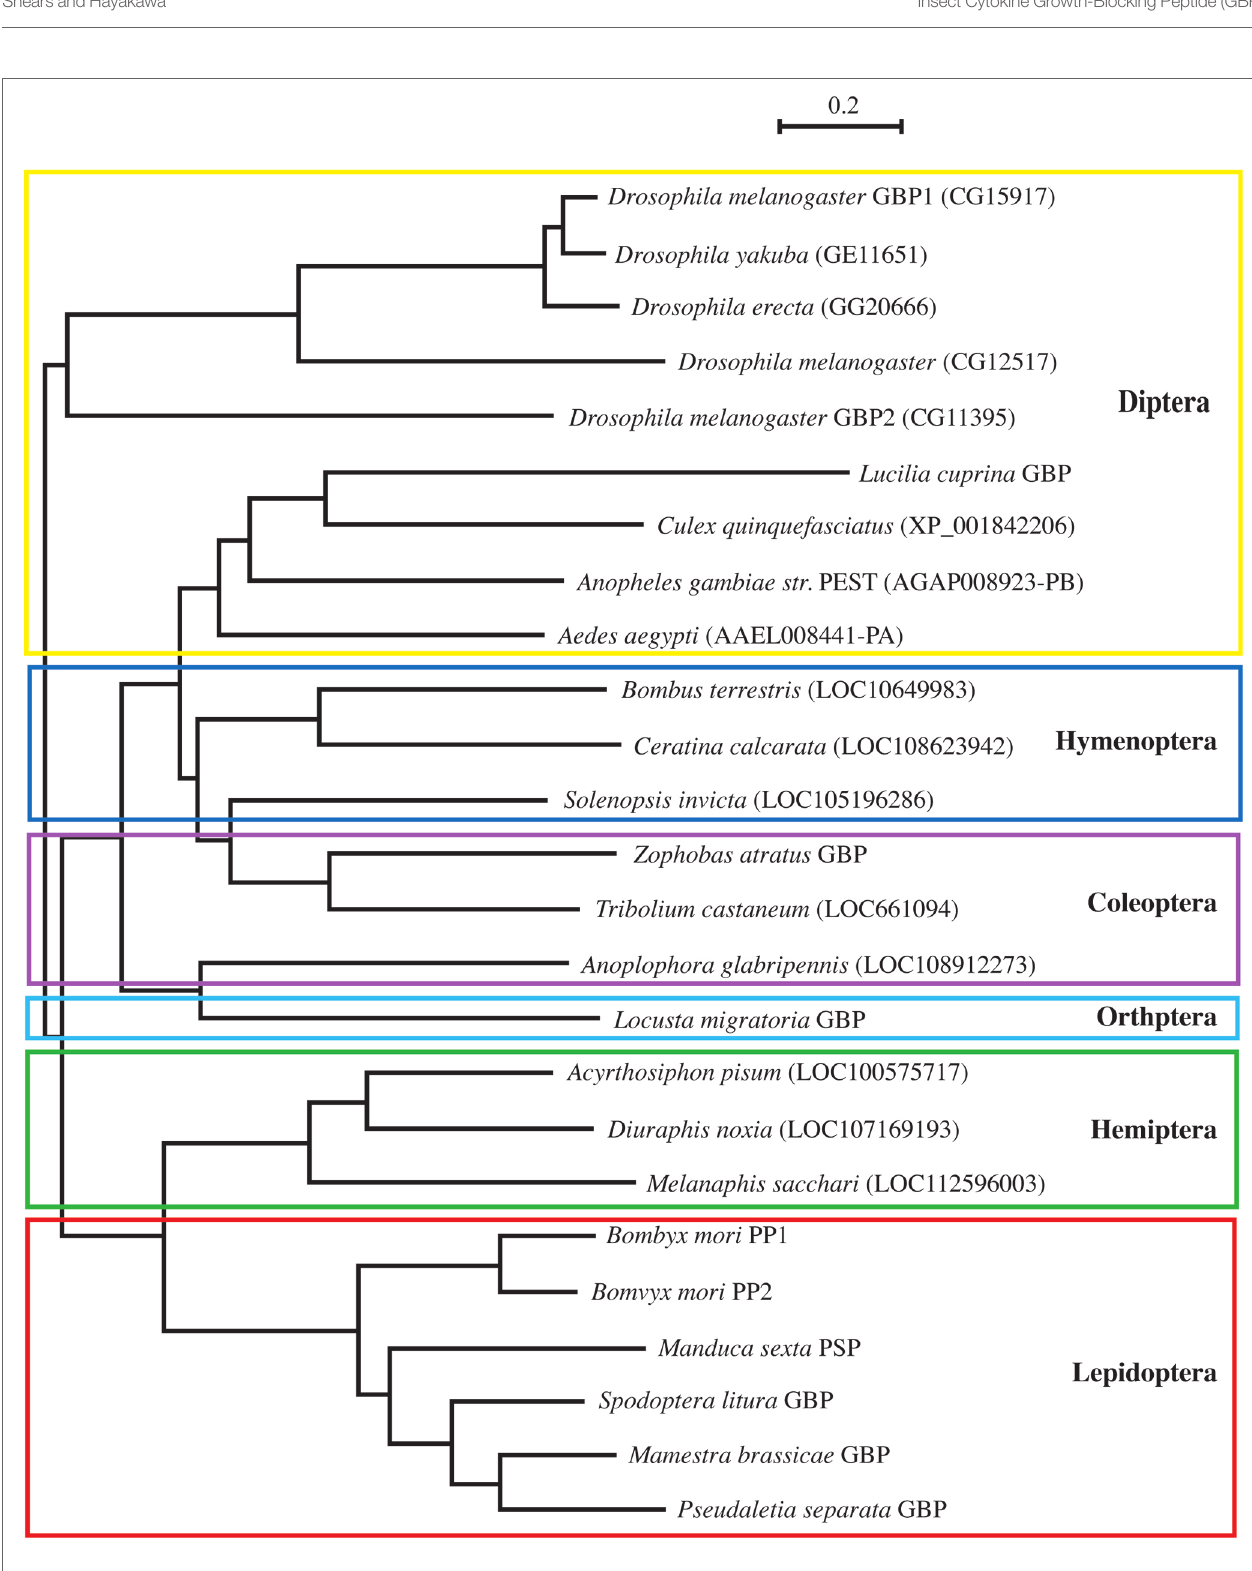
FIGURE 1 | A phylogenetic tree derived from precursor polypeptide sequences of GBP and GBP-like gene family spanning six orders of insects by using the neighbor-joining method with protein-Poisson distances (Saitou and Nei, 1987). The following sequences were identified on database of the NCBI/Blast: Diuraphis noxia LOC107169193 (XP_015374346.1), Melanaphis sacchari LOC112596003 (XP_025197225.1), Solenopsis invicta LOC105196286 (XP_011160410), Ceratina calcarata LOC108623942 (XP_017878339), and Anoplophora glabripennis LOC108912273 (XP_018572983). Locusta migratoria GBP was reported by